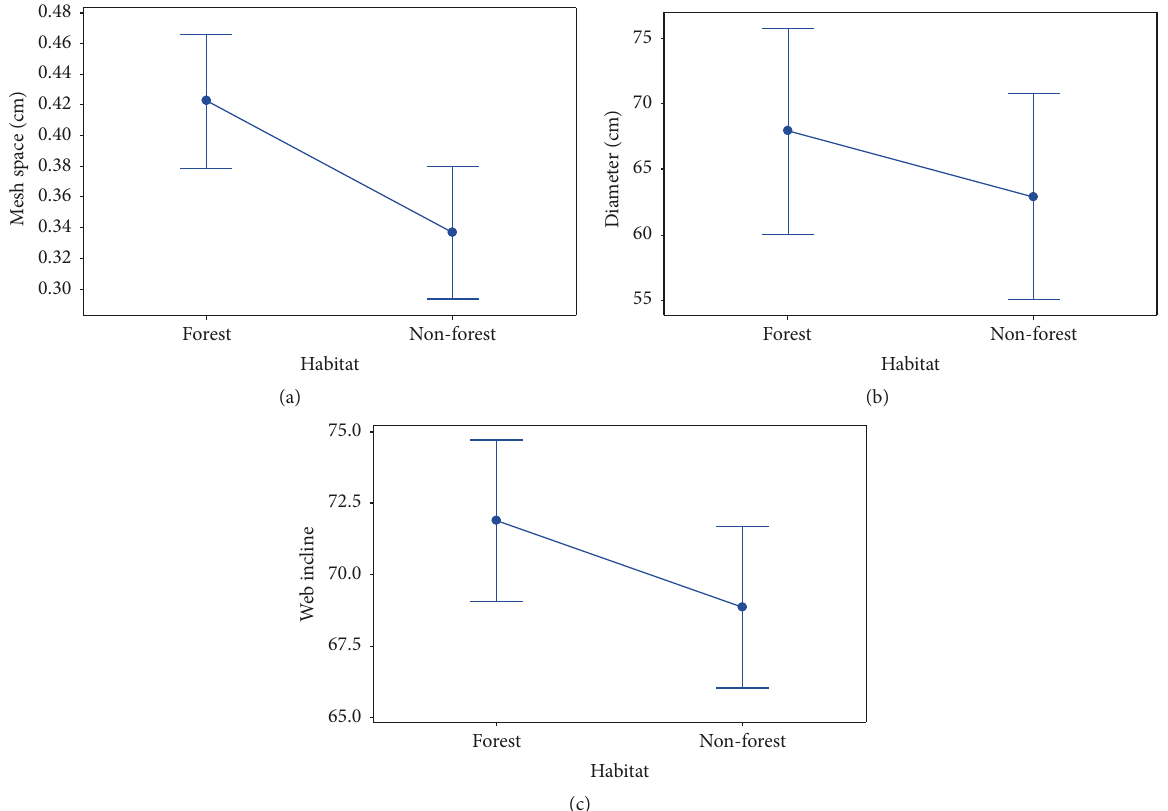
Figure 1: Web architectural properties (a) mesh size, (b) horizontal diameter, and (c) incline in N. pilpes inhabiting forest and nonforest habitats.